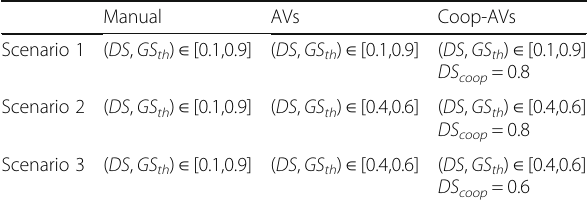
Table 1 Parameters per scenario and vehicle type Manual AVs